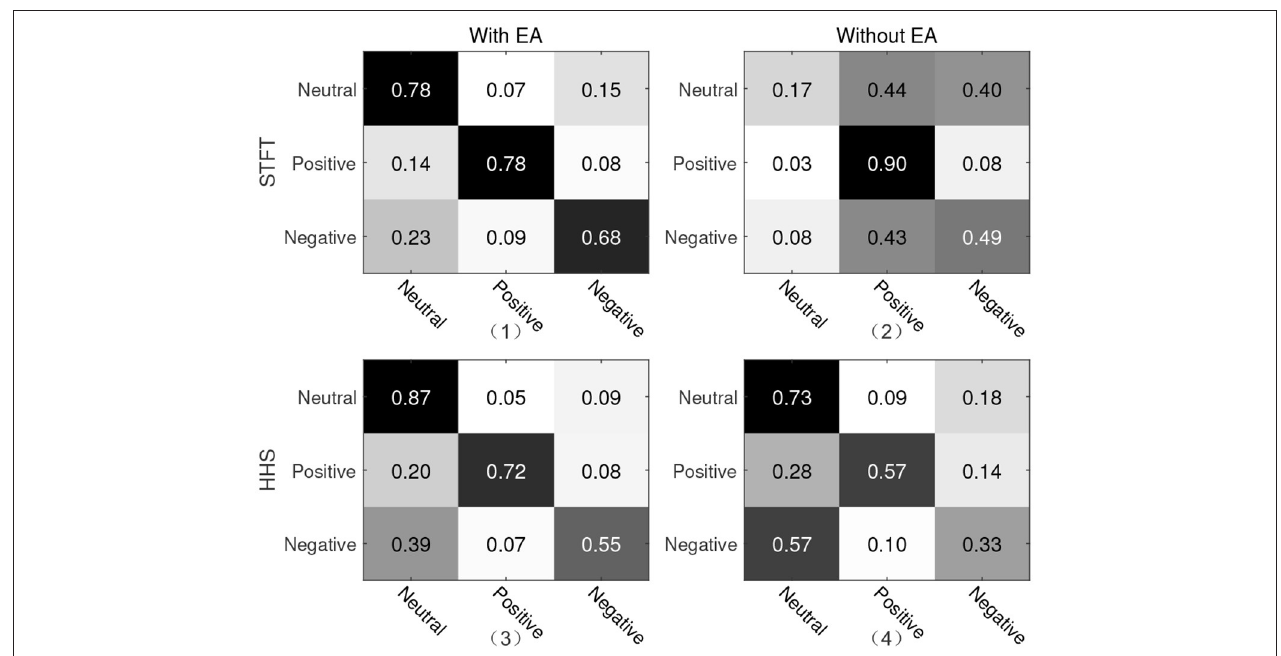
FIGURE 5 | Confusion matrix of protocol two. The vertical axis is the true label and the horizontal axis is the predicted label. (1) and (2) are the recognition results of STFT features; (3) and (4) are the recognition results of HHS features; (1) and (3) are with Euclidean alignment (EA) module, while (2) and (4) are the recognition result without the EA